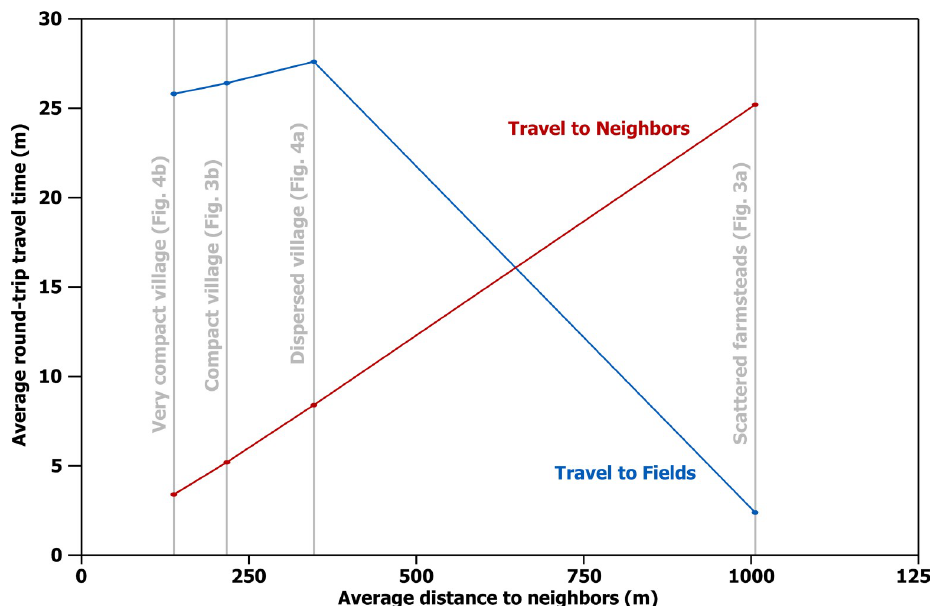
Fig 5. Walking times. Average round-trip walking time to cultivated fields (blue) and neighbors (red) for each of the four household distributions in Figs 3 and 4 (gray).